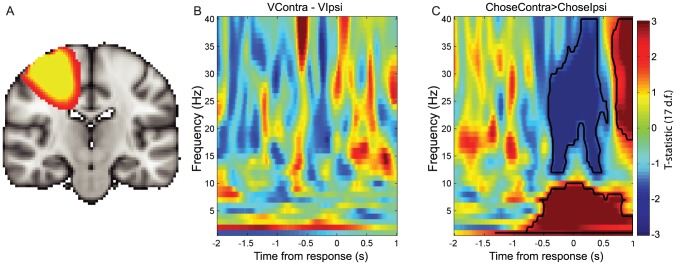
Motor cortex beta band desynchronisation reflects choice, but not value, on ‘comparison’ trials.(A) Statistical parametric map for contrast of beta band (13–30 Hz) activity for right buttonpresses>left buttonpresses, 500 ms–1000 ms after decision presentation (thresholded at T(17)>2.91, p<0.005 uncorrected, for display purposes). Warm colors reflect decreased beta desynchronisation in right hemisphere (ipsilateral to movement). (B) Correlates of value difference between the options contralateral and ipsilateral to the hemisphere, timelocked to the response. Color represents T-statistic; the absence of any bordered region reflects the absence of any significant clusters surviving multiple comparisons correction. (C) Contrast of trials on which chosen option was contralateral vs. ipsilateral to the hemisphere. Bordered areas reflect significant clusters (cluster-corrected P<0.05; permutation test).